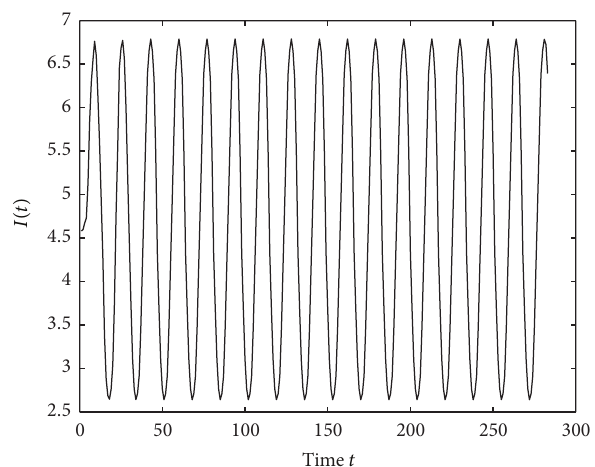
Figure 6: (𝑡,𝐼(𝑡)) , for 𝜏 > 𝜏 0 .